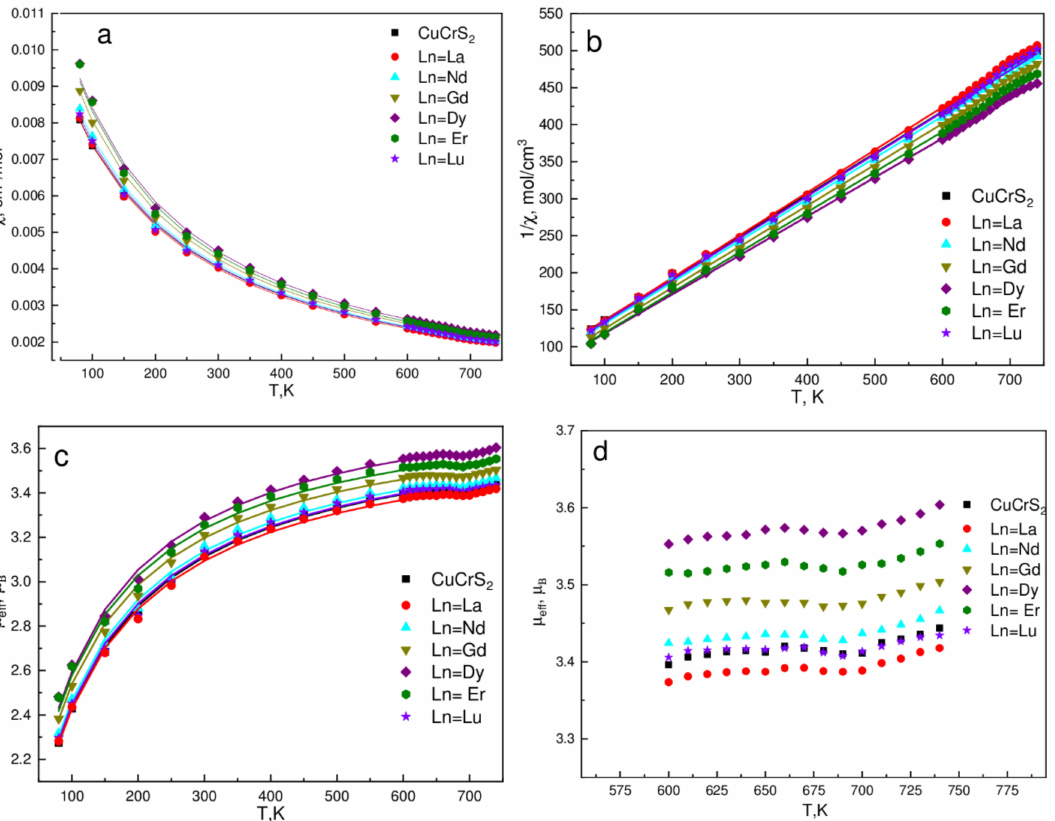
Figure 3. Molar magnetic susceptibility ( a ), inverse magnetic susceptibility ( b ), and effective magnetic moment ( c , d ), temperature dependencies. Solid lines are Curie-Weiss law